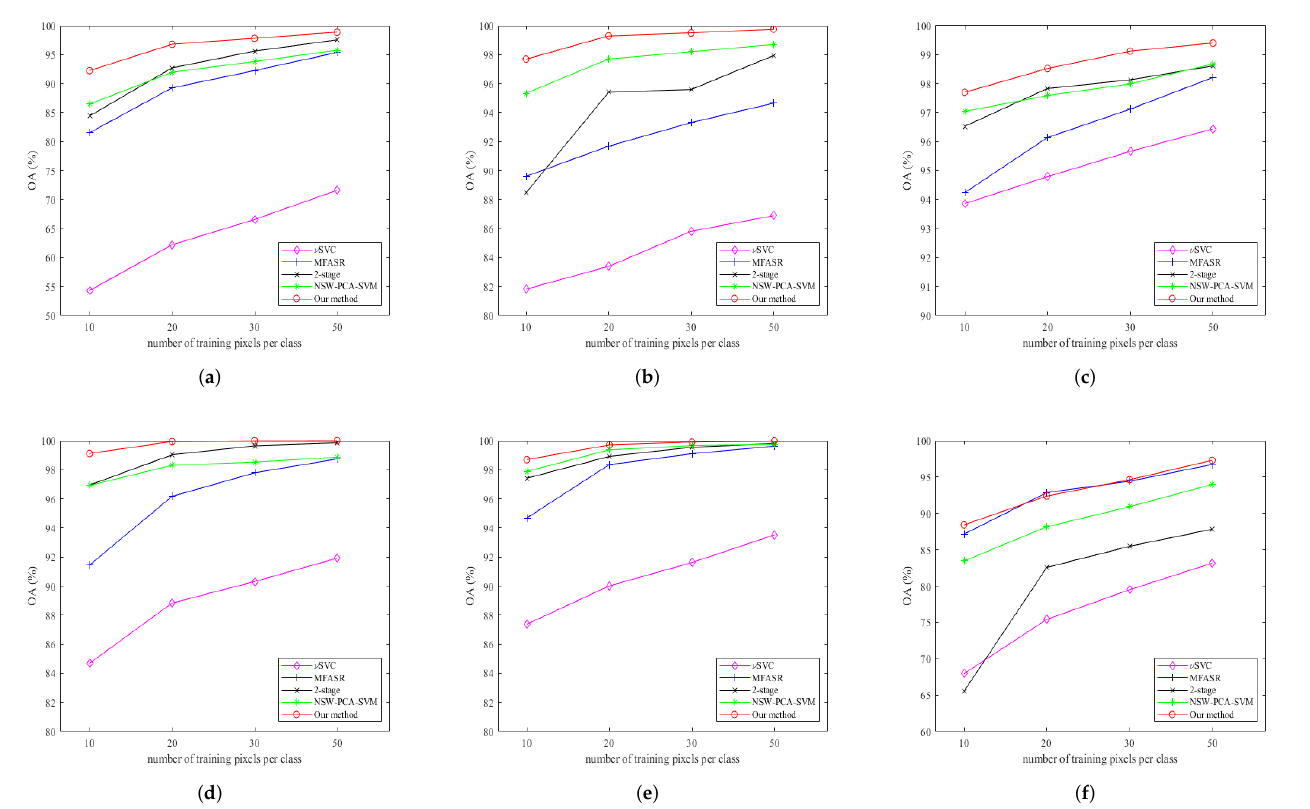
Figure 6. OAs ( y -axis) for different datasets with a different number of training pixels ( x -axis). ( a ) OA on the Indian Pines dataset; ( b ) OA on the Salinas dataset; ( c ) OA on the Pavia Center dataset; ( d ) OA on the KSC dataset; ( e ) OA on the Botswana dataset; ( f ) OA on the PaviaU